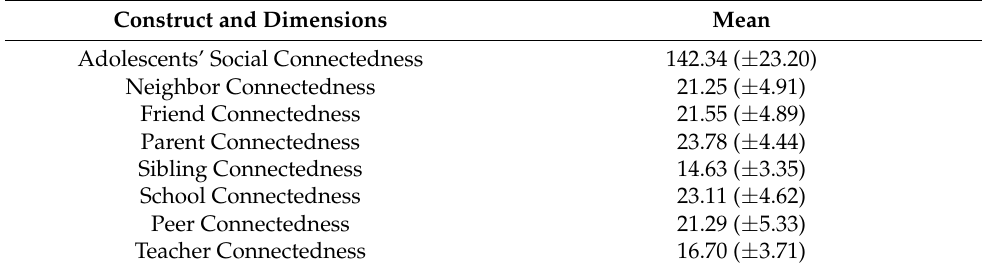
Table 2. Descriptive information on adolescent connectedness. Construct and